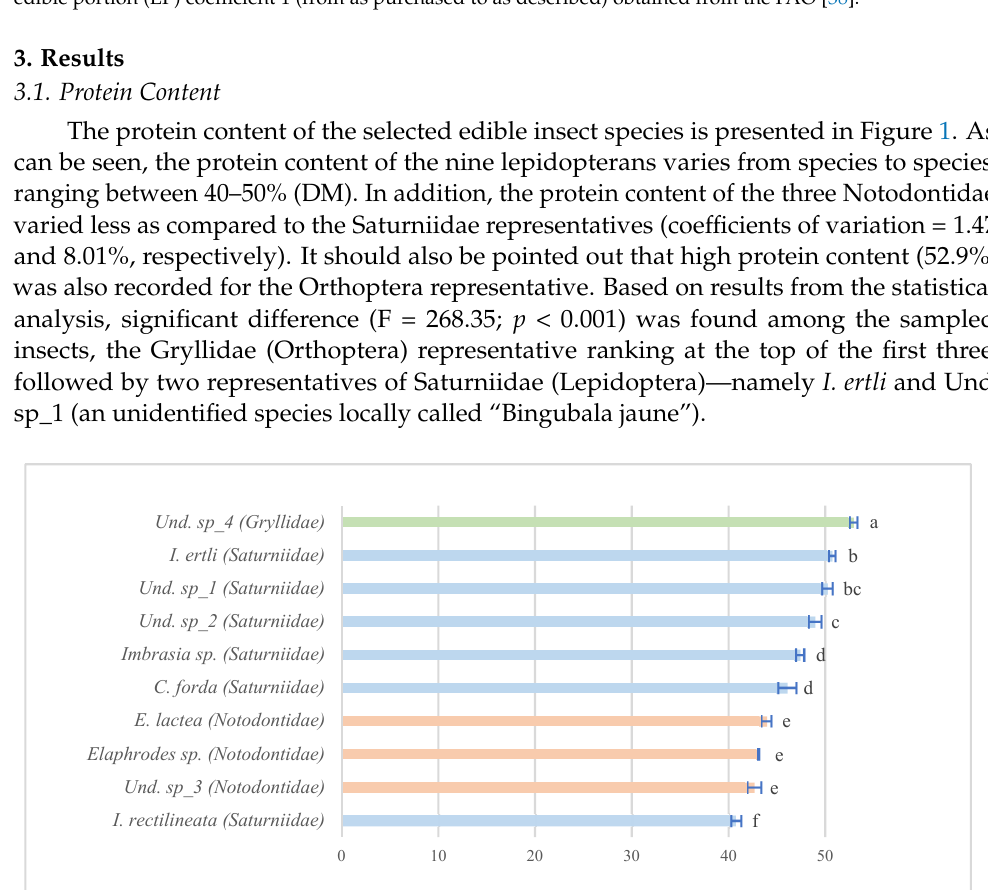
Figure 1. Protein content (g/100 g DM basis) of sampled edible Lepidoptera (Saturniidae or Notodontidae) and Orthoptera (Gryllidae) representatives. Different superscript letters denote a significant difference between sampled species ( p < 0.001) .